Question: Give a one-sentence summary of this figure.
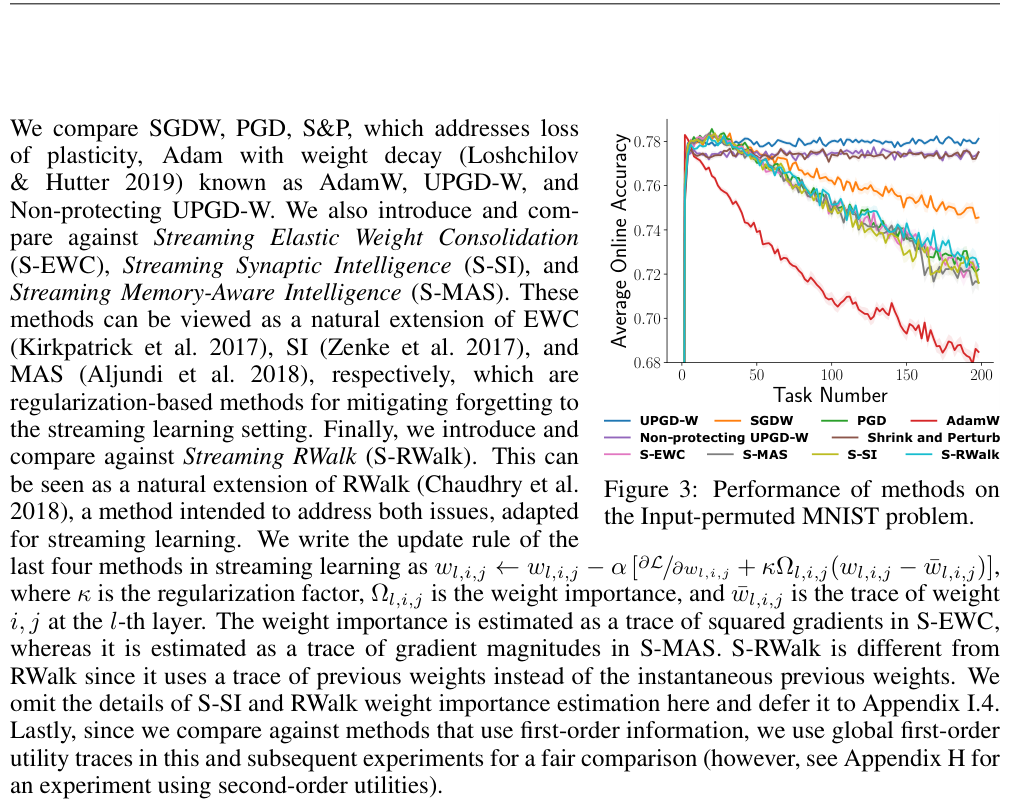
Answer: Performance of methods on the Input-permuted MNIST problem.